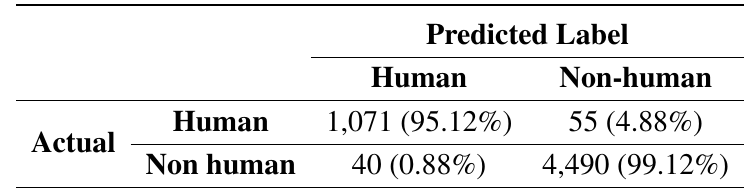
Table 6. Confusion matrix of the final HoG-SVM classifier on the INRIA test set. The percentages in parenthesis are computed horizontally and correspond to TPR, FNR, FPR and TNR,